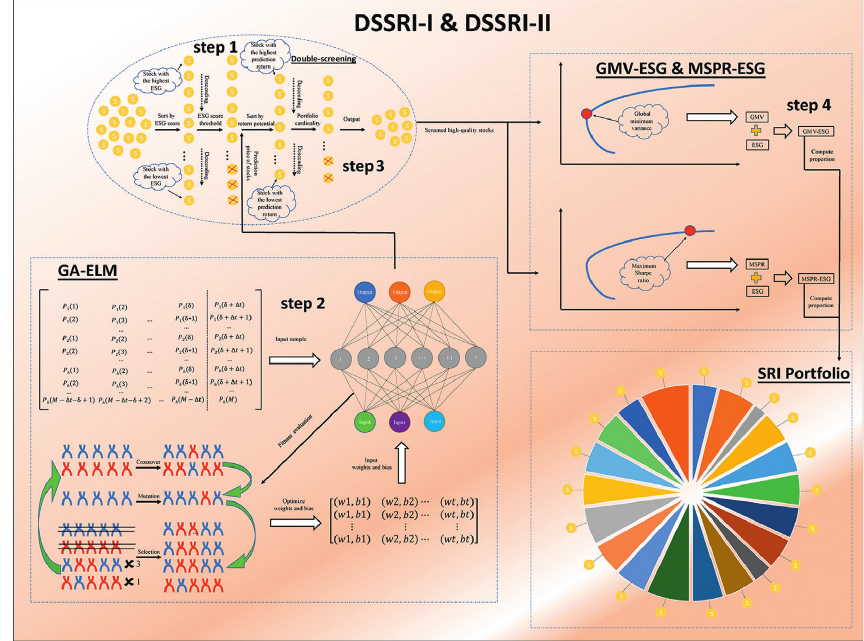
Figure 1: Flowchart of the proposed DSSRI-I and